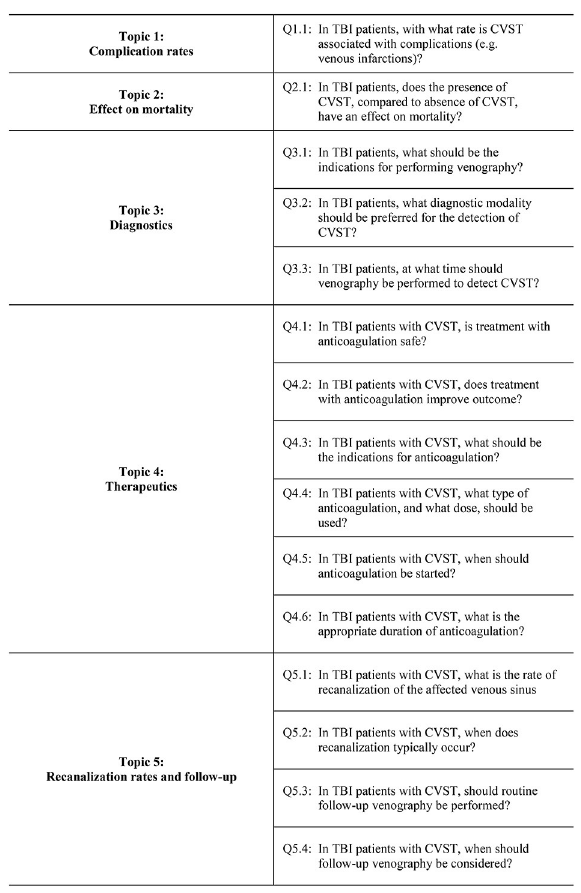
TABLE 1 Key clinical research questions (PICO